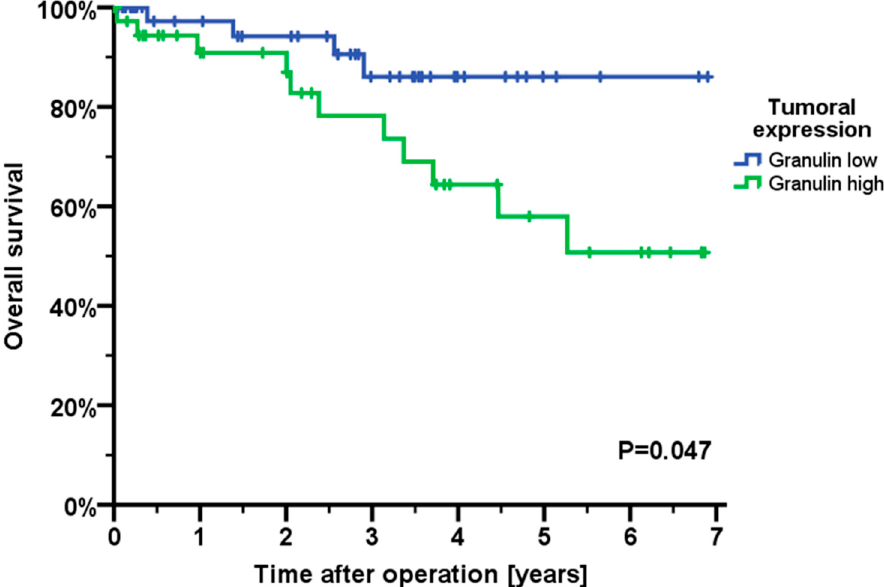
Figure 4. Correlation of granulin expression and overall survival ( n = 89). Overall survival was significantly impaired in patients with high tumoral granulin expression ( p = 0.047).